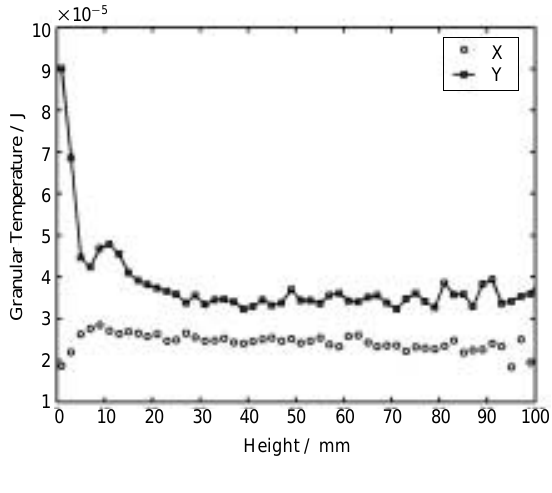
Fig. 6 Granular temperature profile for the system, showing the high fluctuation energy near to the base, which is dissi- pated at